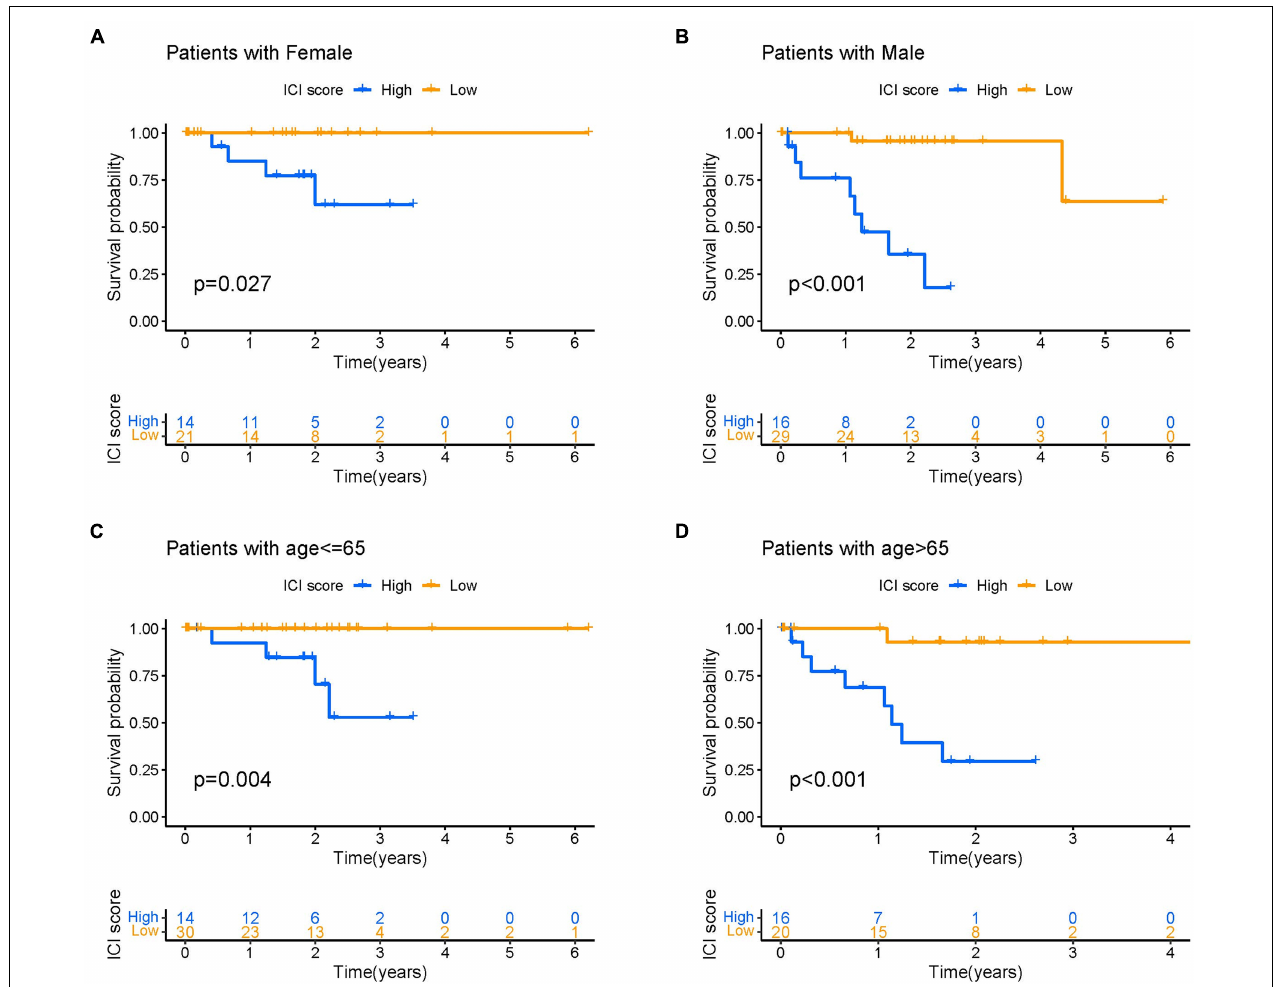
FIGURE 8 | The correlation of ICI scores with patient gender and age. (A,B) Kaplan–Meier curves for the high- and low-ICI scores of female (A) and male (B) UVM patients in the TCGA-UVM and GSE22138 cohorts, respectively. Log-rank test shows overall p = 0.027 and p < 0.001, respectively. (C,D) Kaplan–Meier curves for the high- and low-ICI scores of UVM patients with age ≤ 65 (C) and age > 65 (D) in the TCGA-UVM and GSE22138 cohorts, respectively. Log-rank test shows overall p = 0.004 and p < 0.001, respectively. UVM, uveal melanoma; ICI, immune cell